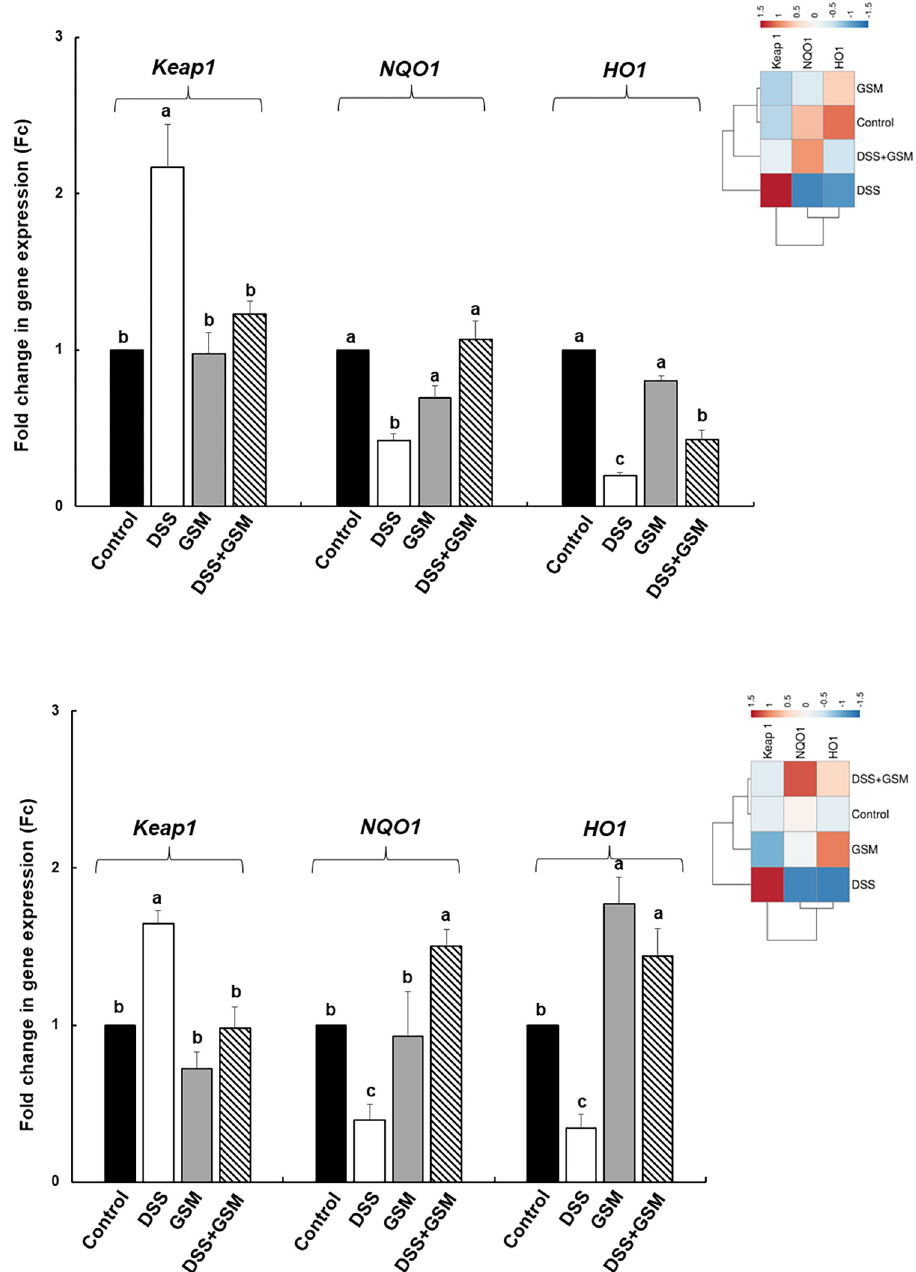
Fig 6. The effect of DSS and dietary GSM treatment on the expression of genes coding for Keap1/Nrf2 signalling pathway in colon (A) and mesenteric lymph nodes (B). Unchallenged and DSS-treated pigs were assigned for 30 days to a Control diet (Control and DSS groups) or 8% GSM diet (GSM and DSS + GSM groups). At the end of the experiment, colon and lymph nodes samples from all animals (n = 5) were collected and analysed for gene expression (qPCR). a, b, c = Histograms for each group with unlike superscript letters were significantly different ( p < 0.050). The heatmap (right panels) represents of Keap1 , NQO1 and HO1 mRNA levels in colon (A-right panel) and mesenteric lymph nodes (B–right panel) collected from piglets. The blue and red colours correspond to low and high gene expression, respectively.